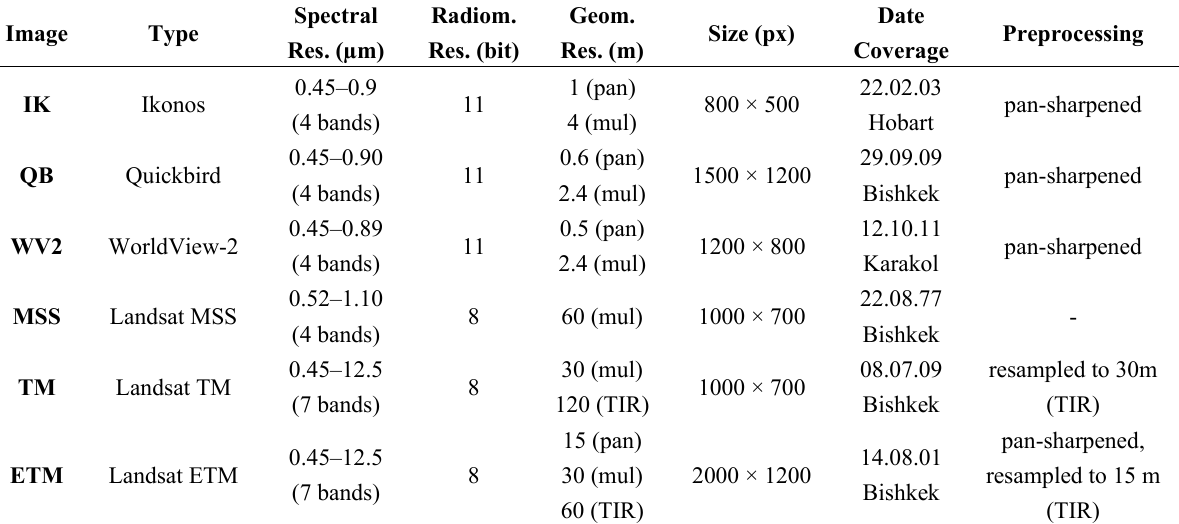
Table 1. Satellite images, their specifications and applied preprocessing